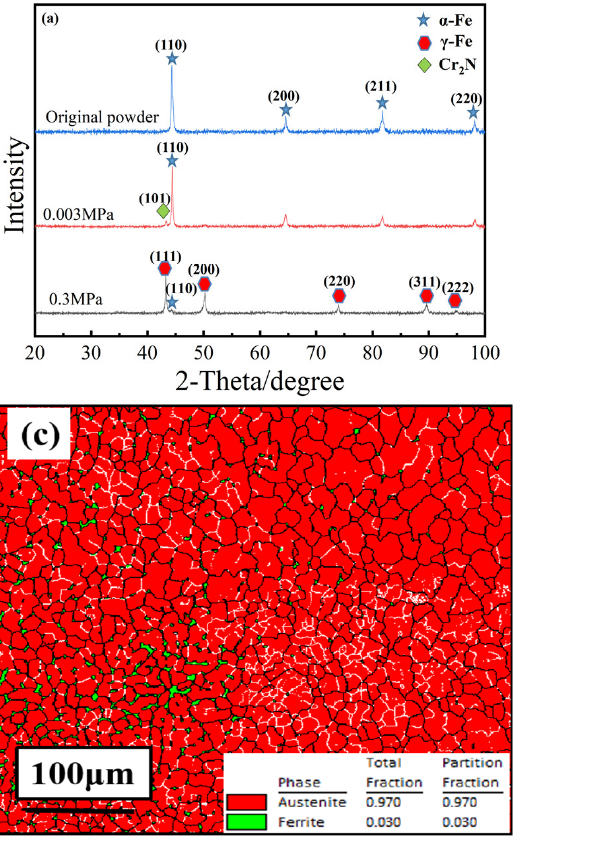
Figure 5. Phase composition of the samples with different nitrogen contents: ( a ) XRD results for samples; ( b ) nitrogen content of the samples; ( c ) EBSD results for the 0.3 MPa sample; ( d ) EBSD results for the 0.003 MPa sample.